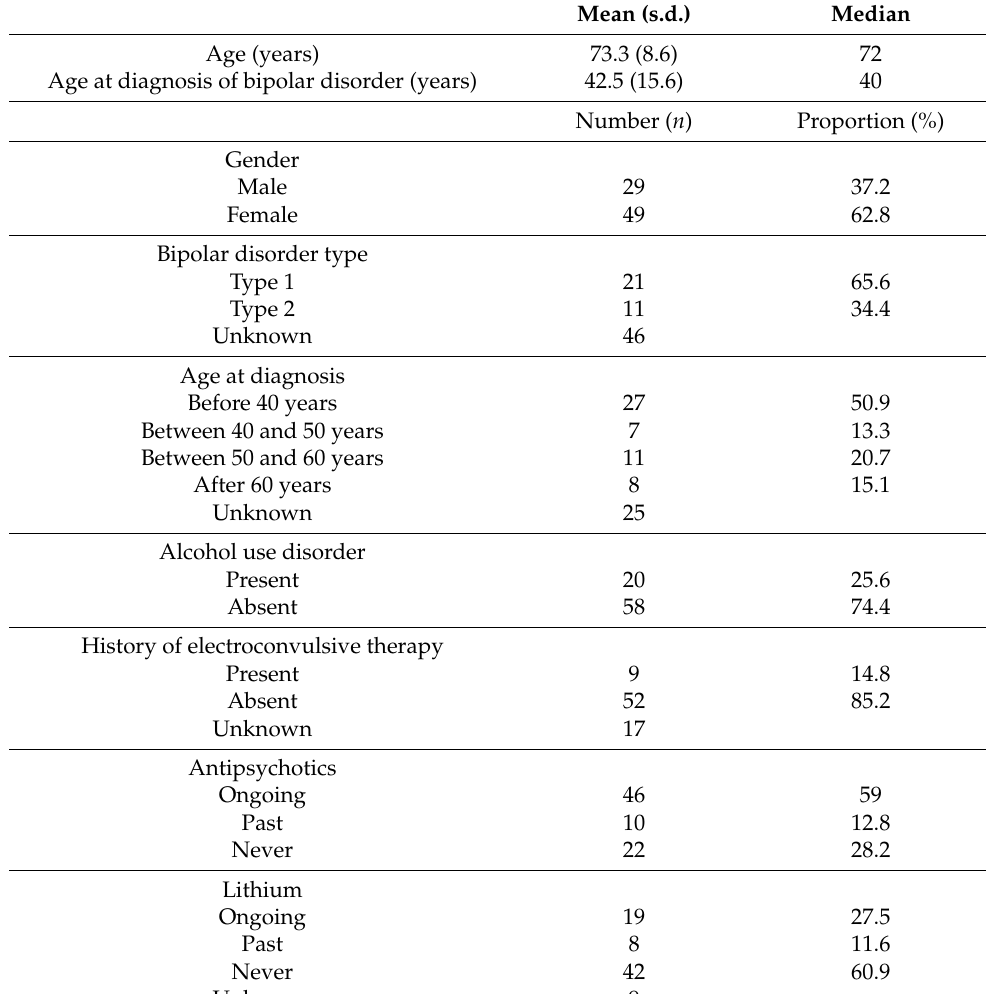
Table 2. Bipolar disorder history and